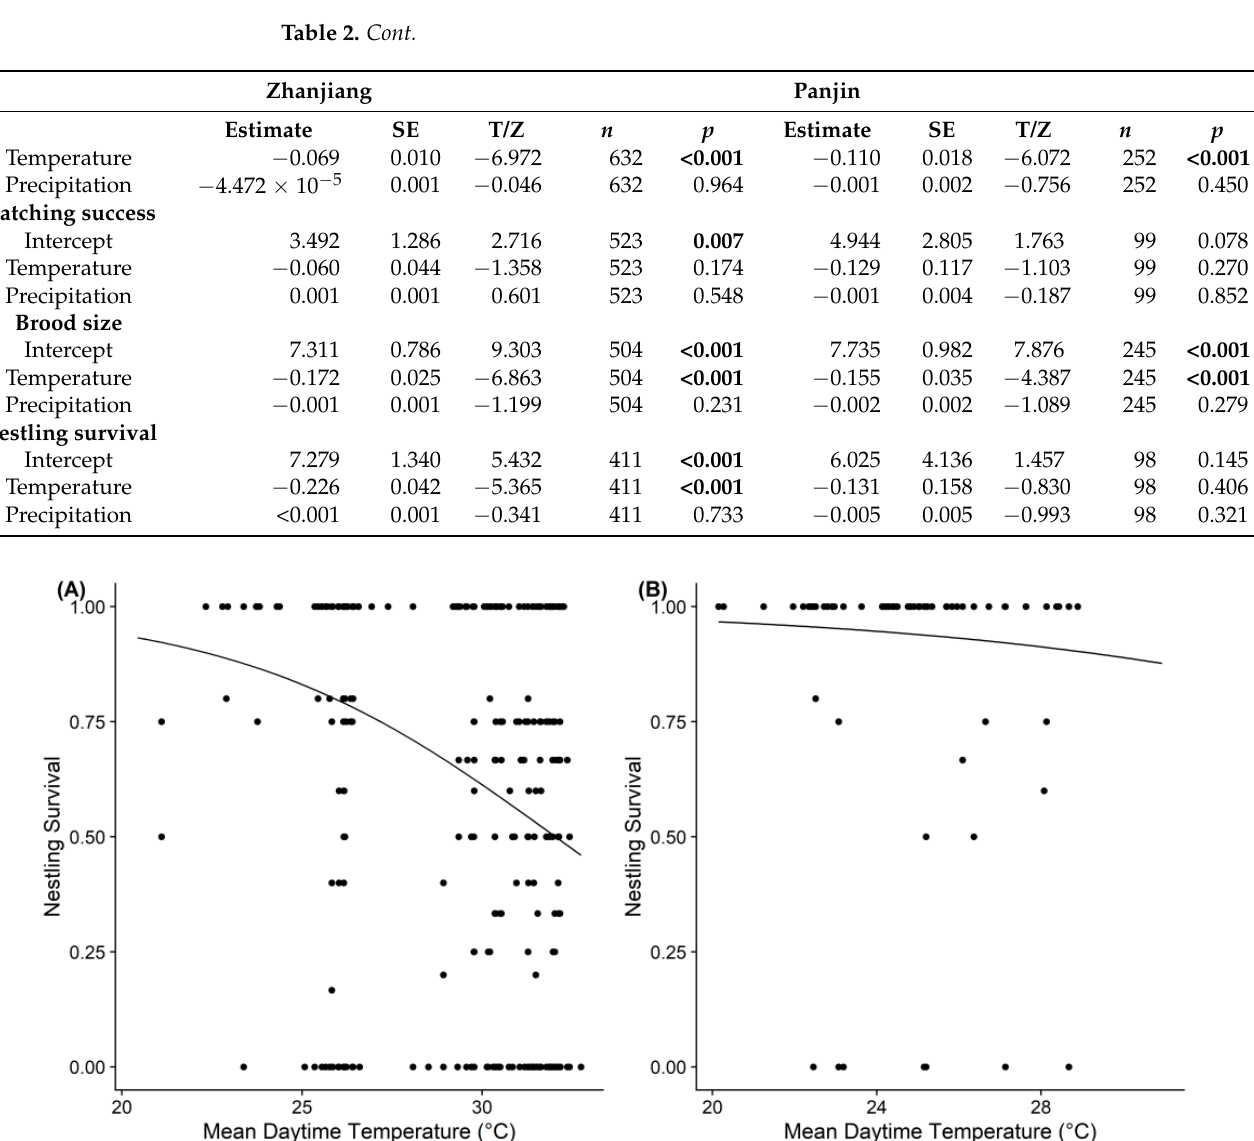
Figure 3. Mean daytime temperature in the brooding period had a negative effect on nestling survival at the tropical site ( A ), but not at the temperate site ( B ). The figure shows the fitted regression lines of GLMMs.